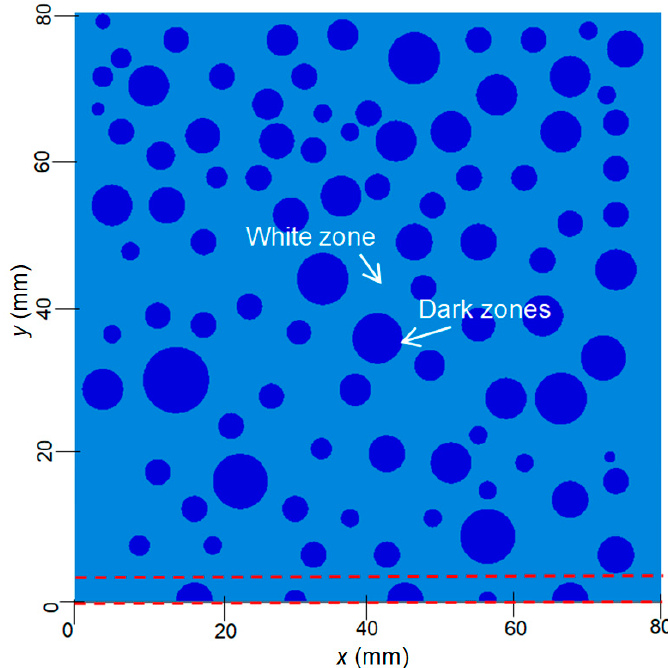
Figure 12. 2D spatial distribution of circular non-uniformities in mica paper with dimensions 80 × 80 mm (red lines are y = 0 mm and y = 3 mm).